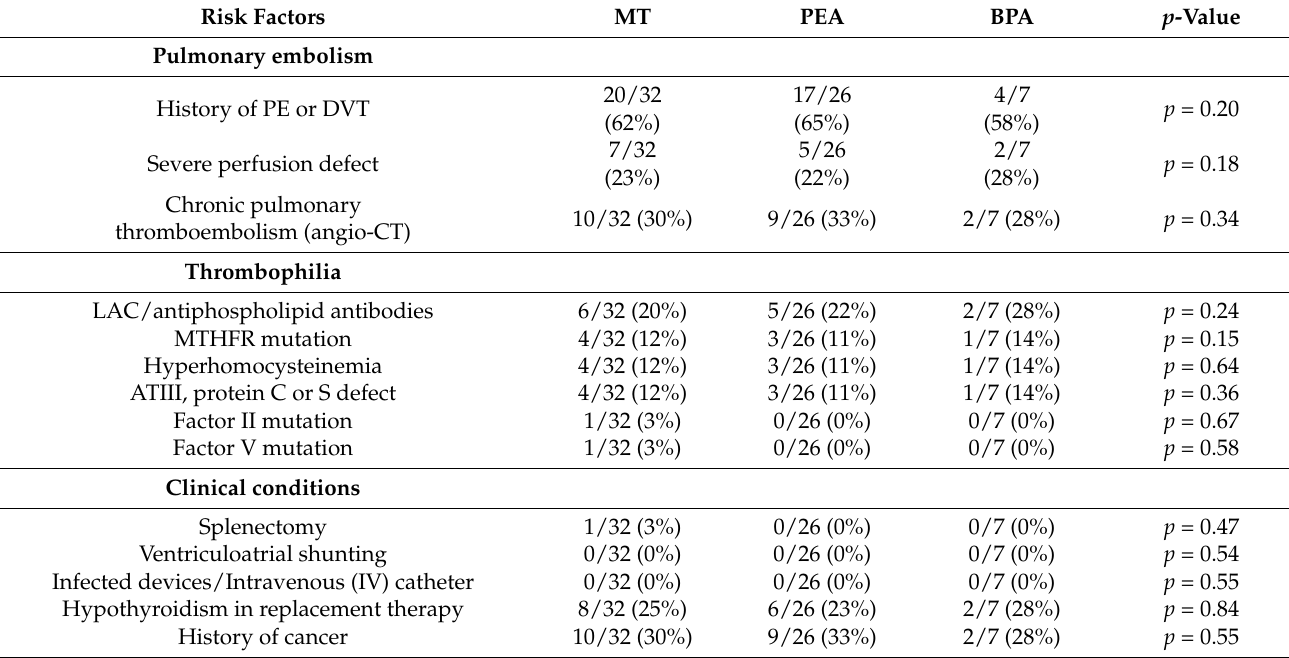
Table 2. Risk factors of the study population at